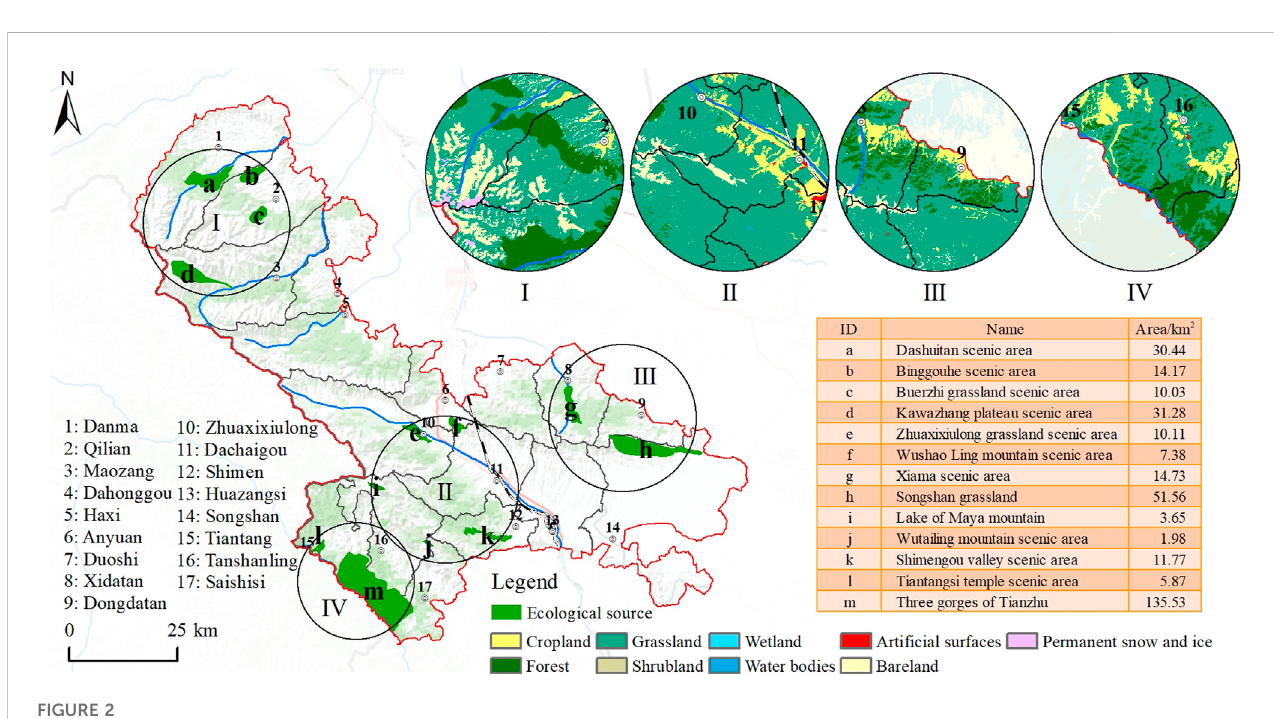
FIGURE 2 Location of the ecological source